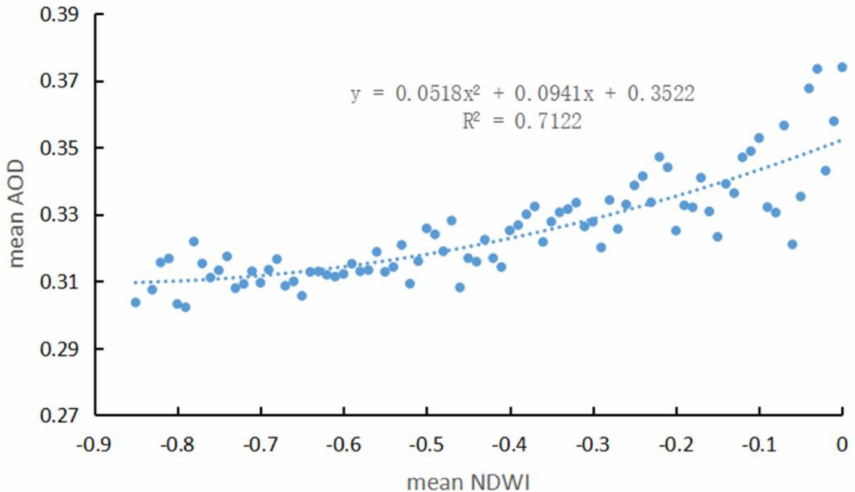
Figure A3. Relationship between NDWI (Normalized Difference Water Index) and associated AOD (Aerosol Optical Depth) values in the NDWI range of − 1 to 0. Table 1. Pearson correlations among the AOD values and the LULC-related variables. AOD NDVI NDBI NDWI PerCon. PerForest. PerGreen. PerFarm.